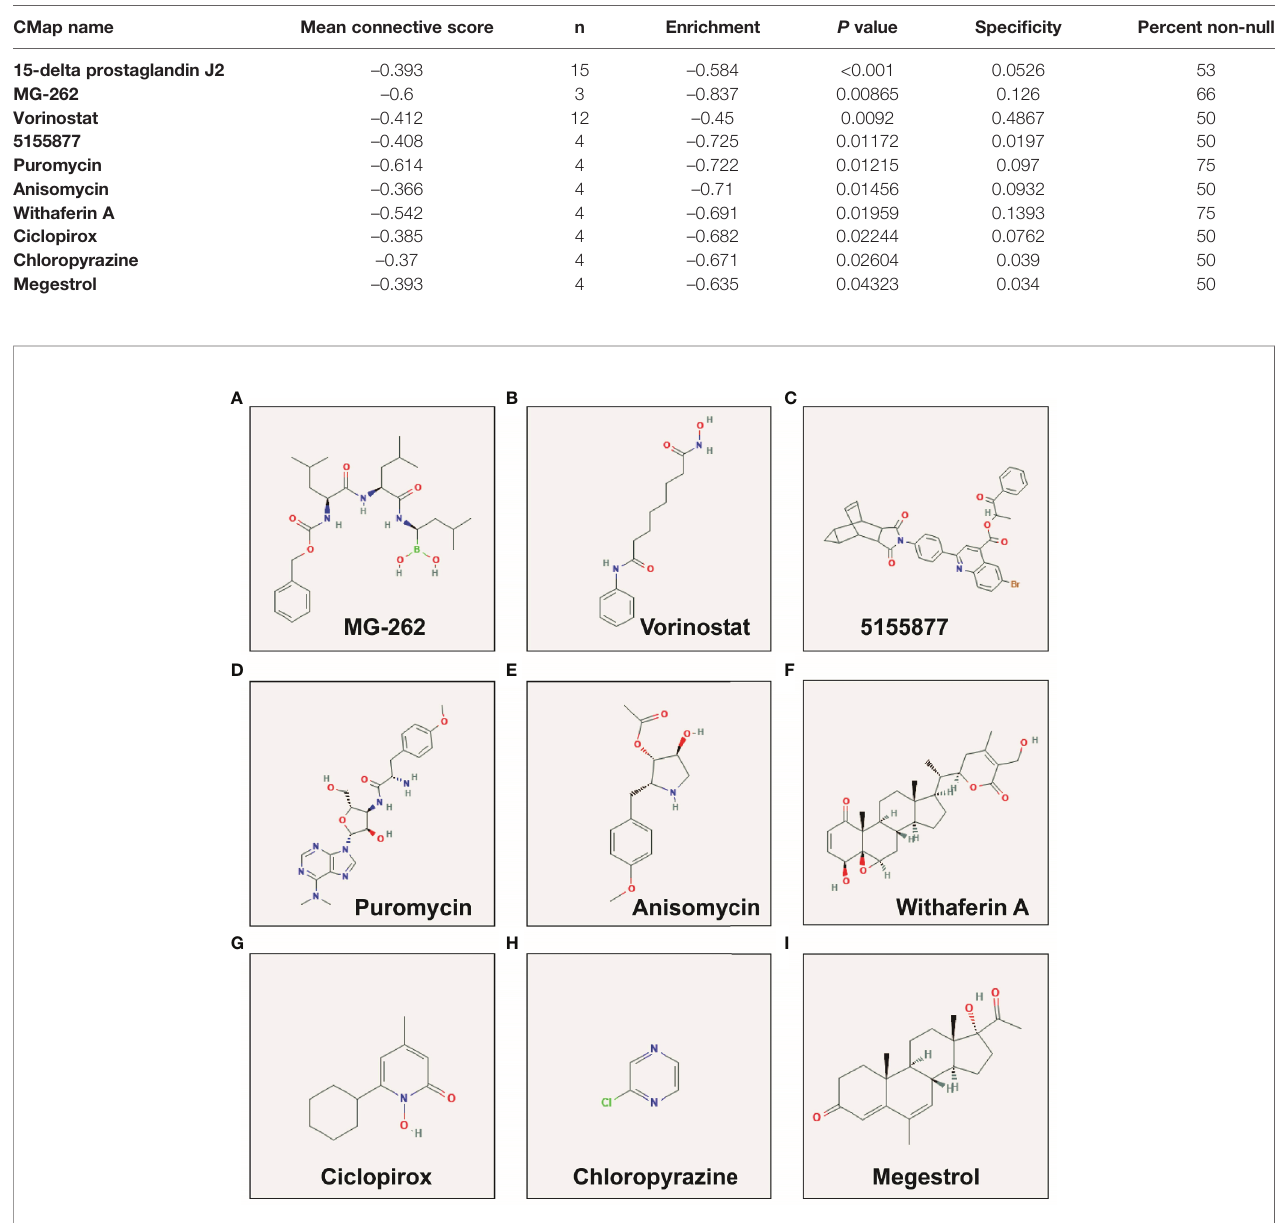
FIGURE 10 | The chemical structure of the targeted therapeutic drugs of snoRNAs prognostic signature in LGG. (A) MG-262; (B) Vorinostat; (C) 5155877; (D) Puromycin; (E) Anisomycin; (F) Withaferin A; (G) Ciclopirox; (H) Chloropyrazine; (I)